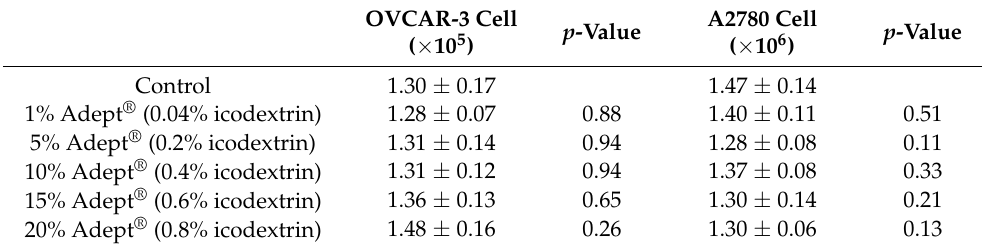
Table 1. Dose-dependent effect of Adept ® on the cell growth of OVCAR-3 and A2780 cell.